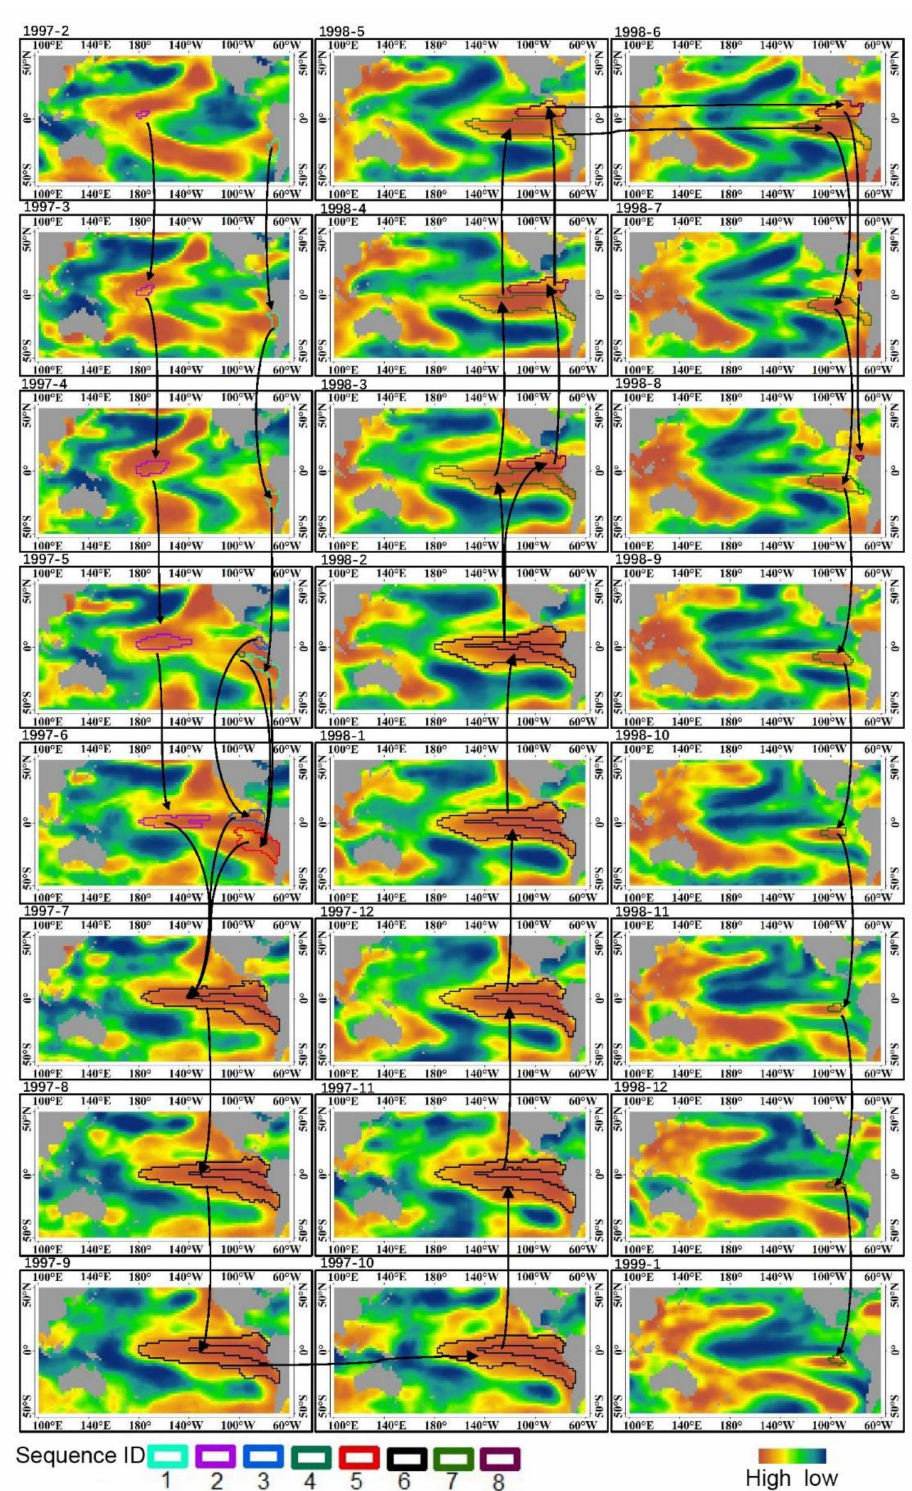
Figure 14. The evolution of an abnormal sea surface temperature variation and its evolutions: The background is made up of monthly anomalies of the sea surface temperature; different colors of the Sequence ID represent different evolution sequences; and the black arrow represents an evolution, developing, merging, or splitting